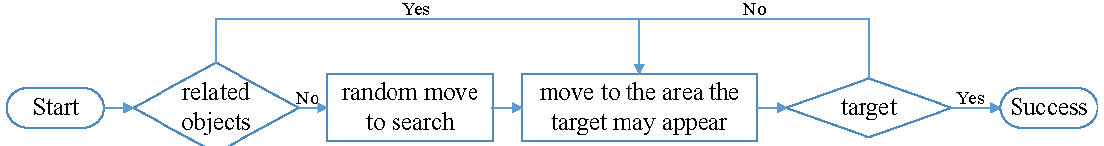
Figure 5. The workflow of the decision node.